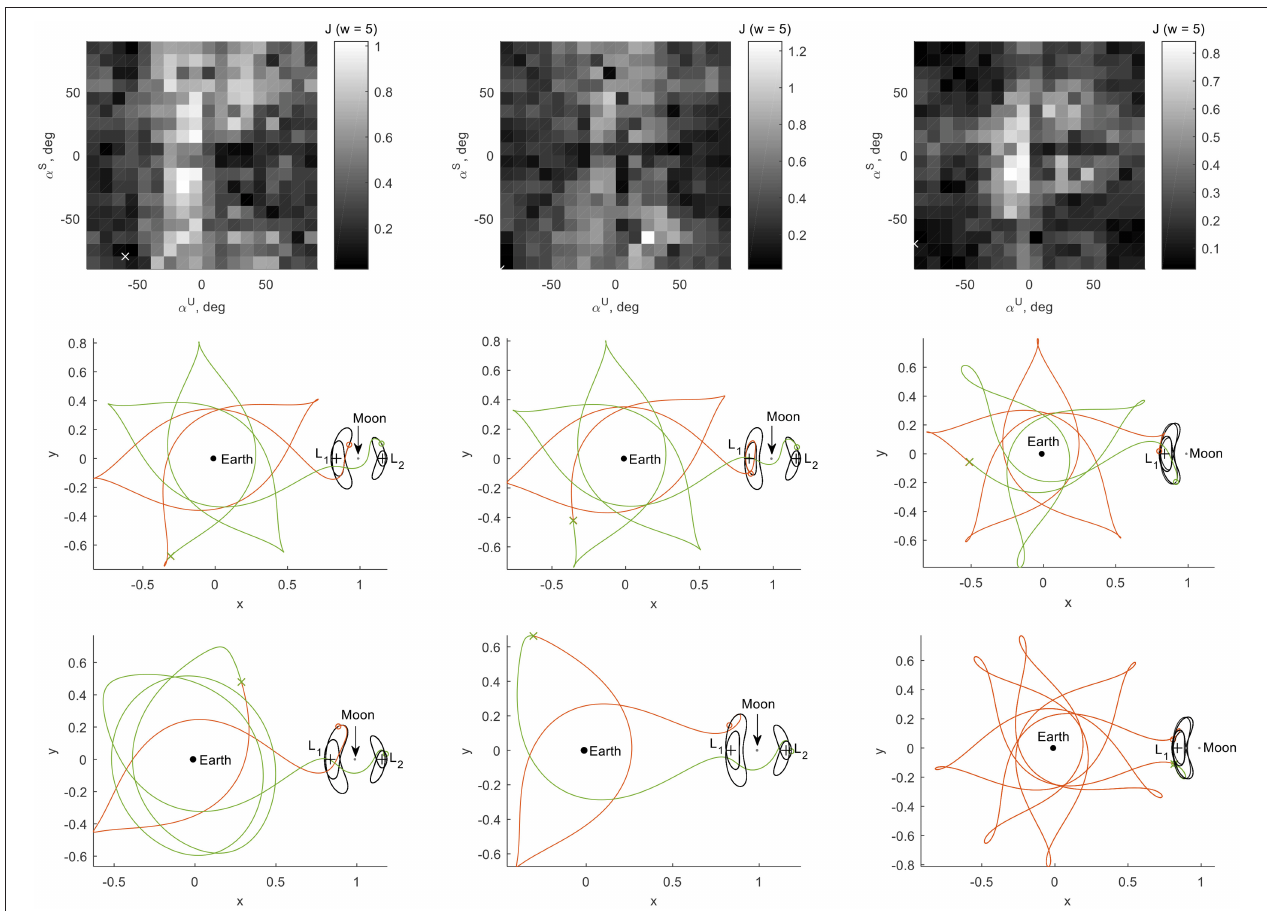
FIGURE 12 | Best heteroclinic connections (FLTR: transfers 4–6) for grid search in pitch angles (top and middle row) and for genetic algorithm approach (bottom row).